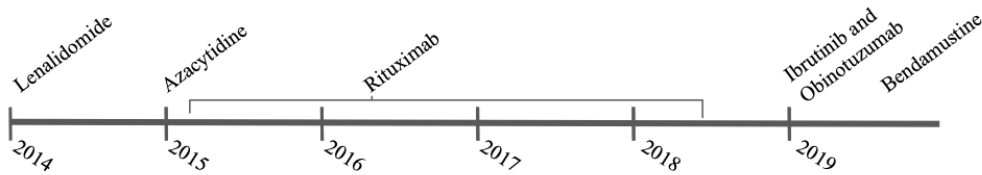
Figure 3. Treatment timeline during patient’s clinical course.